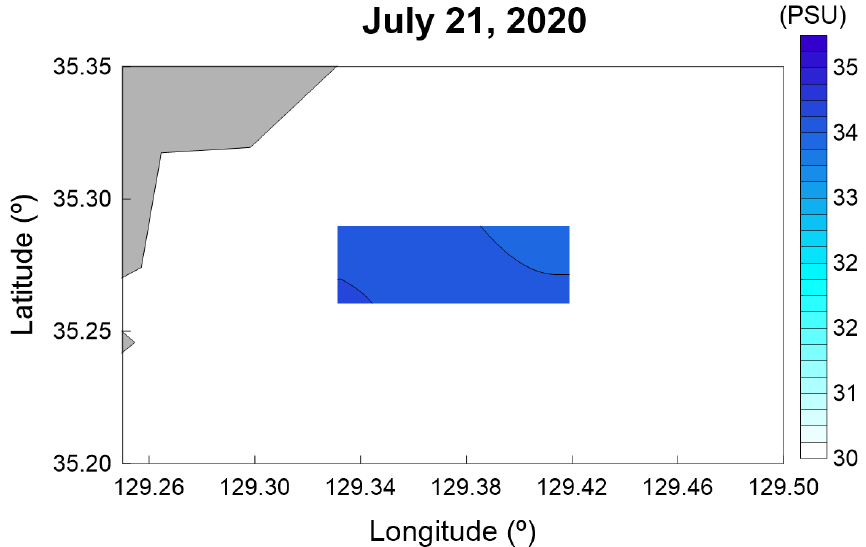
Figure 16. Distribution of salinity in the major swimming layers in the Gijang coastal waters sea (21 July 2020).